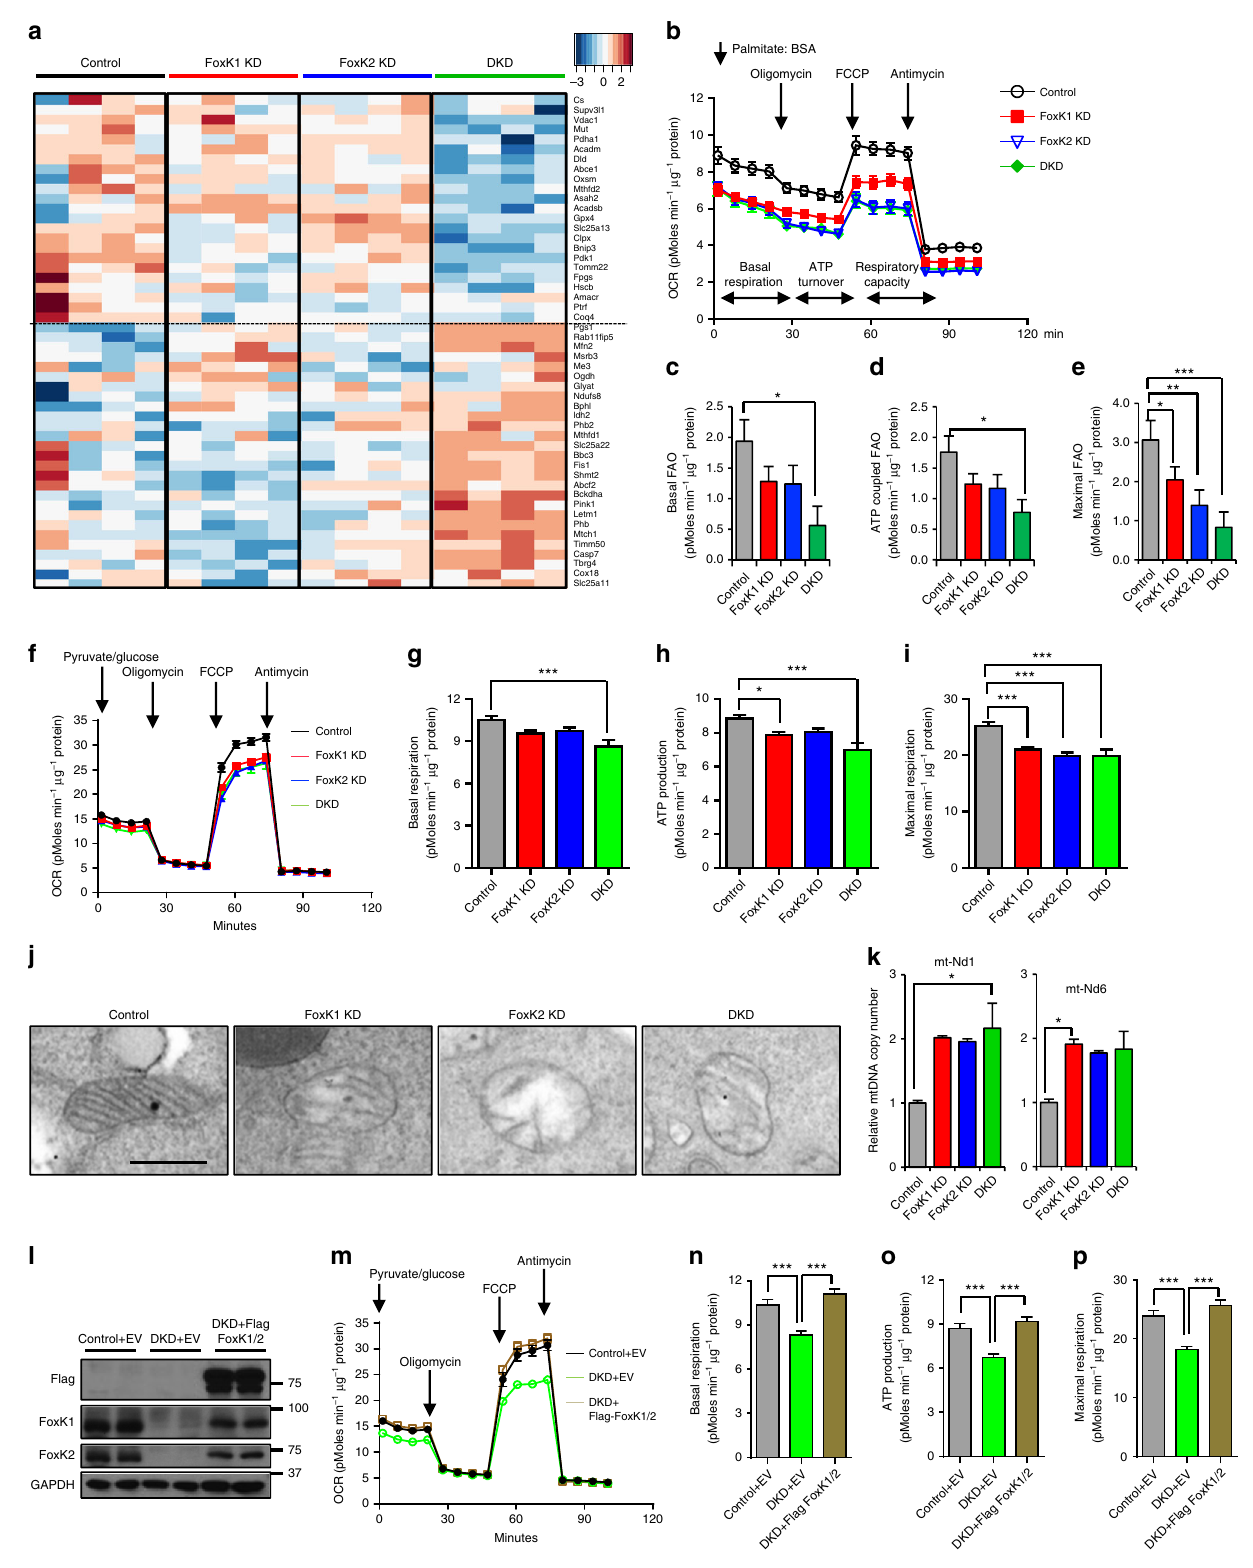
Mice . Mice were maintained on a 12-h light/dark cycle and fed a normal CD (9F5020; PharmaServ). Tissues from 3-month-old male C57BL/6J mice were col- lected and rinsed in PBS. To assess insulin signaling in vivo, 5 U insulin (Sigma- Aldrich) was injected via the inferior vena cava. FoxK1 lox/lox mice were created using a targeting construct with loxP sites fl anking exons 4 and 5 of FoxK1 . These mice were injected via the tail vein with adenovirus encoding Cre recombinase gene to induce recombination in the liver or adenovirus encoding GFP gene as a